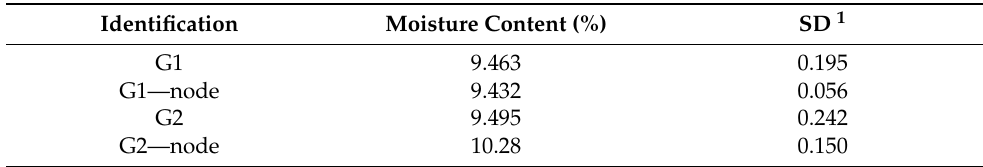
Table 3. Moisture content of